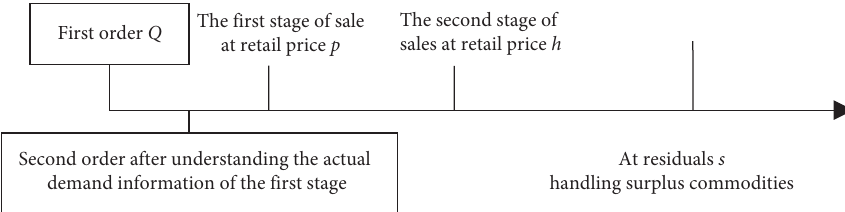
Figure 2: Diagram of operation